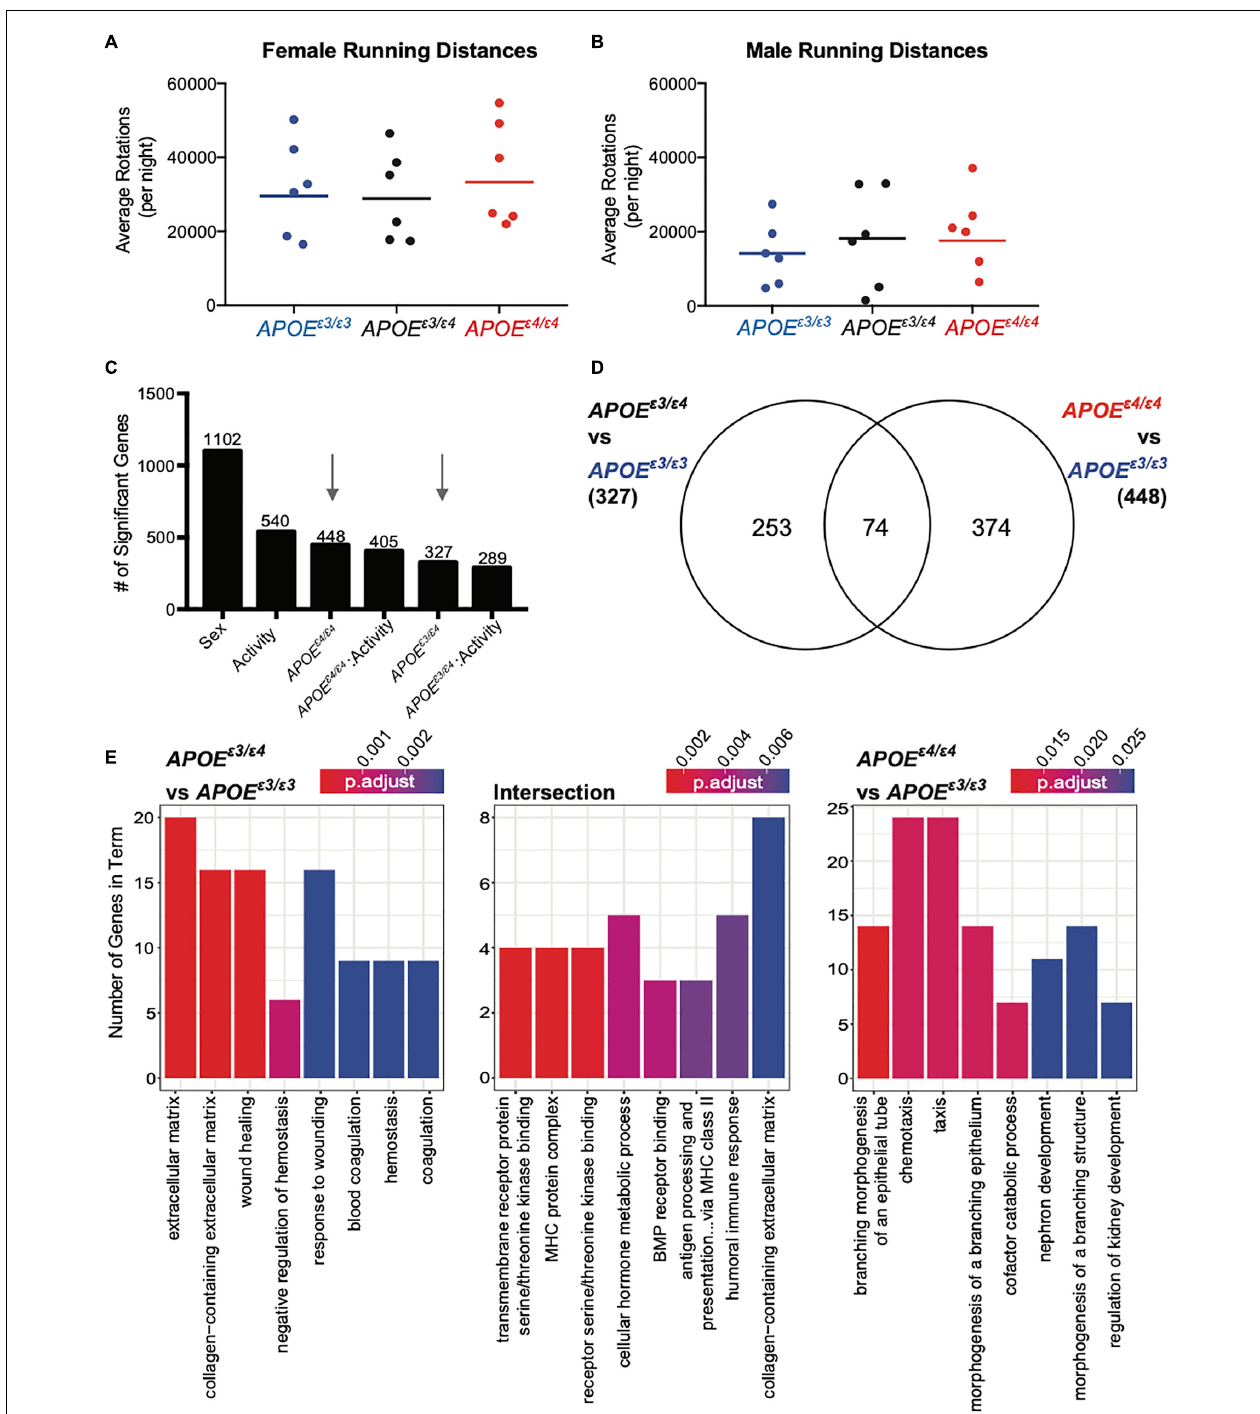
FIGURE 5 | Significant genes unique for APOE ε 3 / ε 4 genotype showed functional enrichment for ‘extracellular matrix’ and ‘response to wounding’ at 4 months. (A,B) Average number of rotations per night during the dark cycle for female (A) and males (B) across all APOE genotypes for the six mice per group that were selected for RNA-seq. Mean is representative of all mice, including those that were not sequenced (see also Supplementary Figure 8 ). (C) Number of significant genes per each linear model predictor term. Red arrows highlight APOE ε 4 / ε 4 and APOE ε 3 / ε 4 terms used in panel (D) . (D) Number of significant genes unique to APOE ε 3 / ε 4 when compared to APOE ε 3 / ε 3 , and APOE ε 4 / ε 4 compared to APOE ε 3 / ε 3 , as well as the number of significant genes intersecting both groups. (E) Functional enrichment of the 253 genes unique to APOE ε 3 / ε 4 compared to APOE ε 3 / ε 3 (left), 374 genes unique to APOE ε 4 / ε 4 compared to APOE ε 3 / ε 3 (right) and 74 intersection genes between the two groups (middle) ( p <